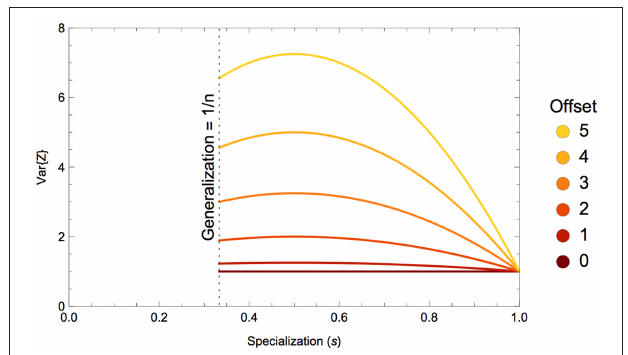
FIGURE 1 | Variance of the isotopic distribution of a consumer’s diet, V { Z } , with respect to specialization on a single prey, s k . This illustrative example shows a three-prey system with prey means and equal variances; colors depect specialization on prey 2 with a mean isotope value that is a function of some offset amount. As the offset of the targeted prey increases, so does the nonlinearity of V